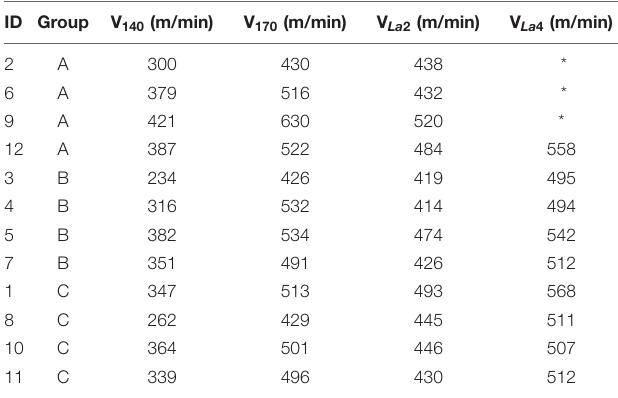
TABLE 3 | Performance parameters derived from the standardized incremental field exercise test on a gallop track (SET track ).